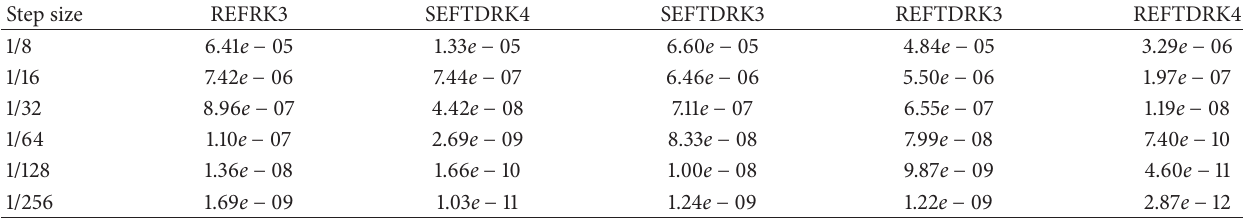
Table 1: The global errors in the final step points obtained by several methods for Problem 1.